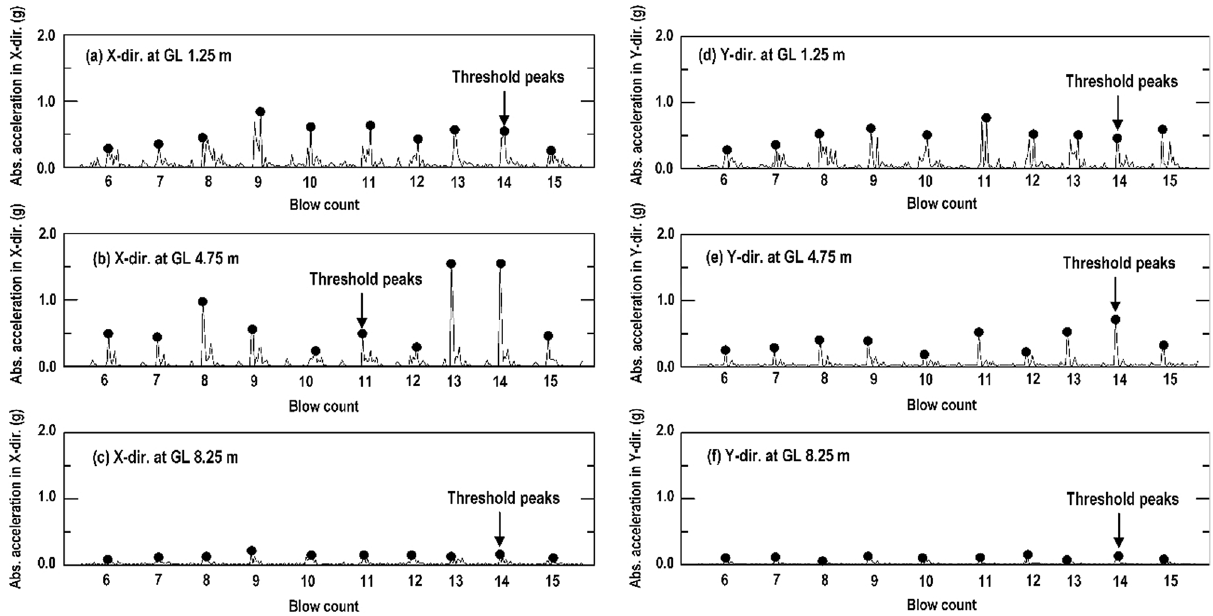
Figure 9. Partial acceleration record and action of POT processing result: ( a – c ) X-direction response at GL values of 1.25, 4.75, and 8.25 m; ( d – f ) Y-direction response at GL values of 1.25, 4.75, and 8.25 m (GL, ground level).